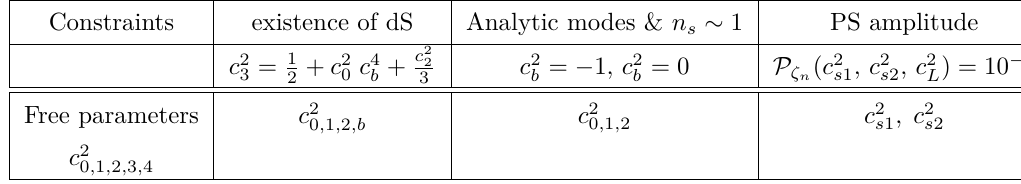
plot. Note the P / P ζ π 0 n